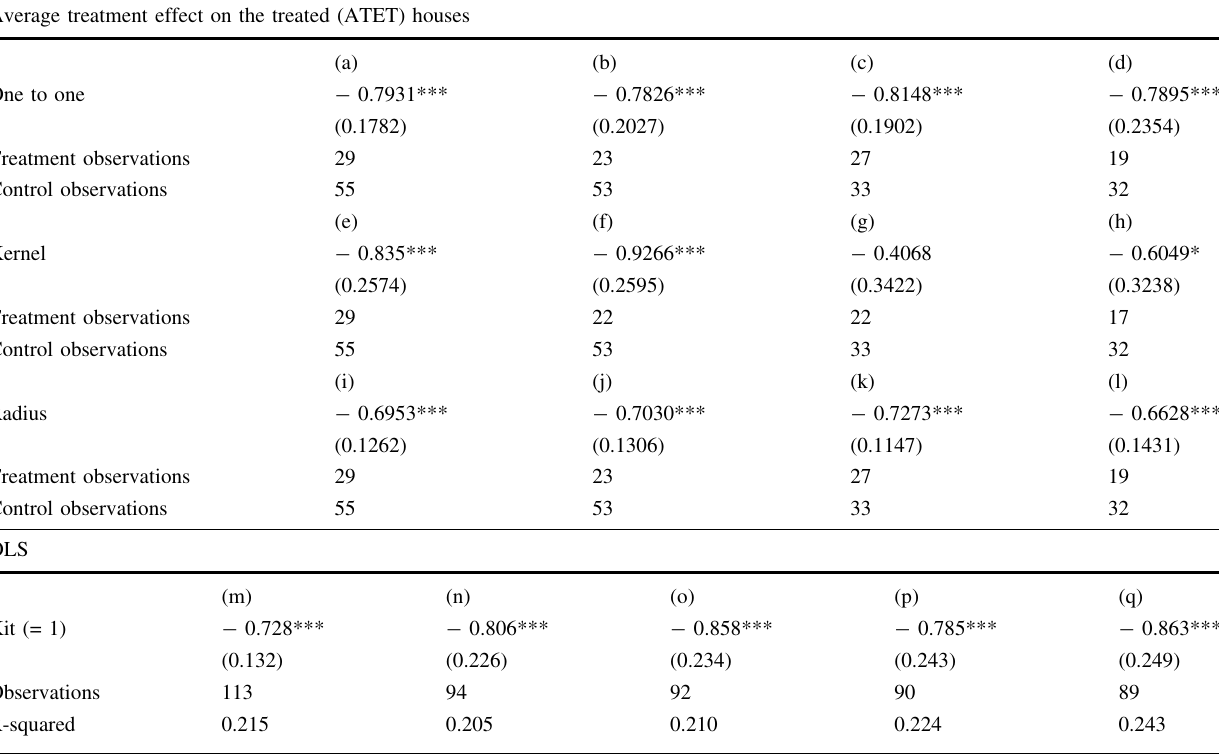
Table 4 Average treatment effect on the treated (ATET) houses in Picsi, Chiclayo Province, Peru´ Average treatment effect on the treated (ATET) houses